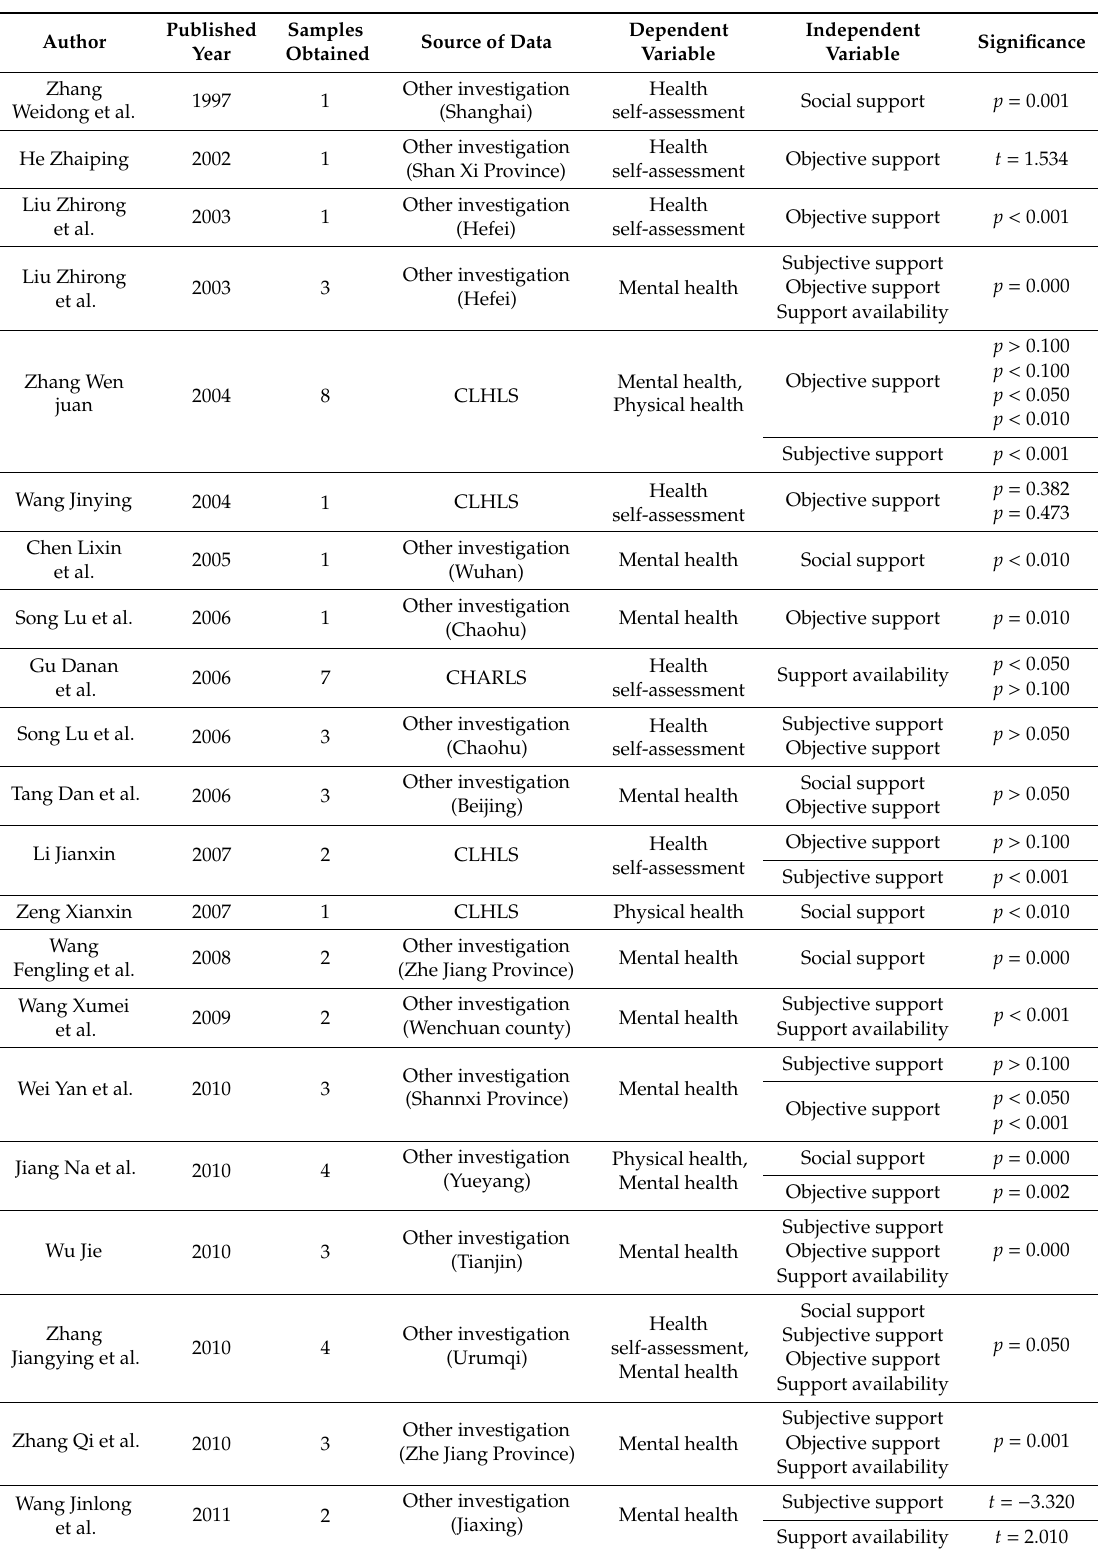
Table A1. A summary of the literature included in the